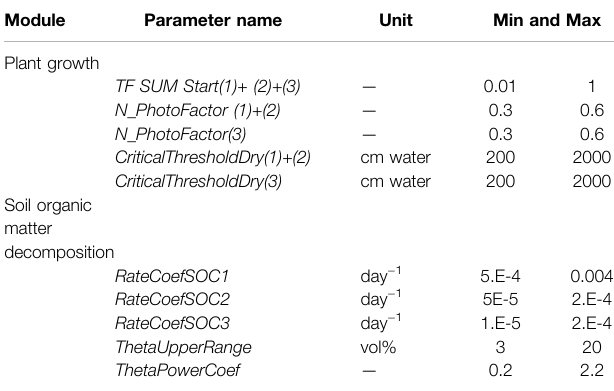
TABLE 1 | Parameter setting, prior range. Plant growth parameters 1 – 3 refer to the three vegetation layers. SOC pool one and two refer to litter pools originating from vascular and moss plants respectively, and the decomposed organic matter